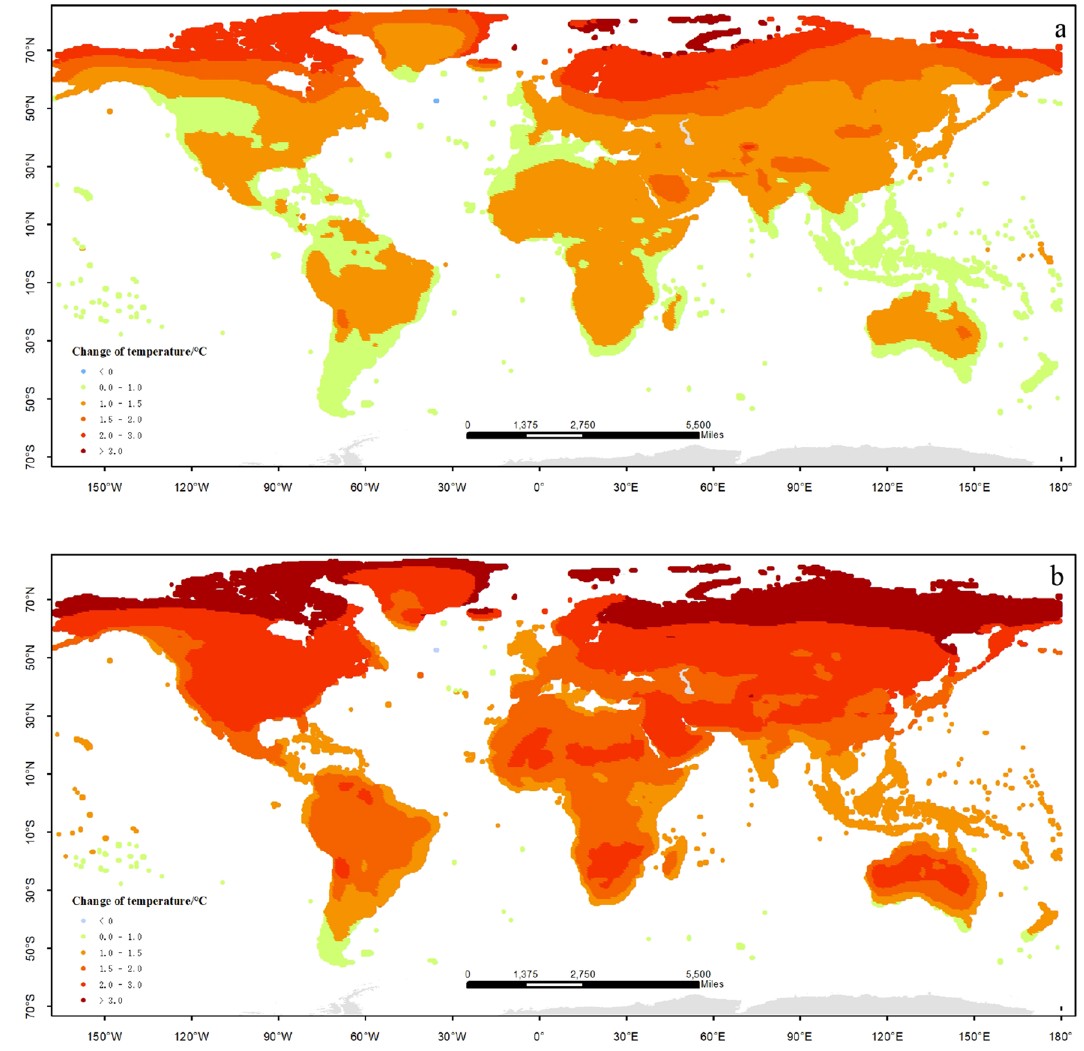
Figure 2. Distribution of temperature and precipitation changes under global warming by 1.5 °C and 2.0 °C ( a ) temperature, 1.5 °C; ( b ) temperature, 2.0 °C; ( c ) precipitation, 1.5 °C; ( d ) precipitation, 2.0 °C. The figure has been generated using ArcGIS 10.2 and Natural Earth-Free vector and raster map data @ https:// natur alear thdata.